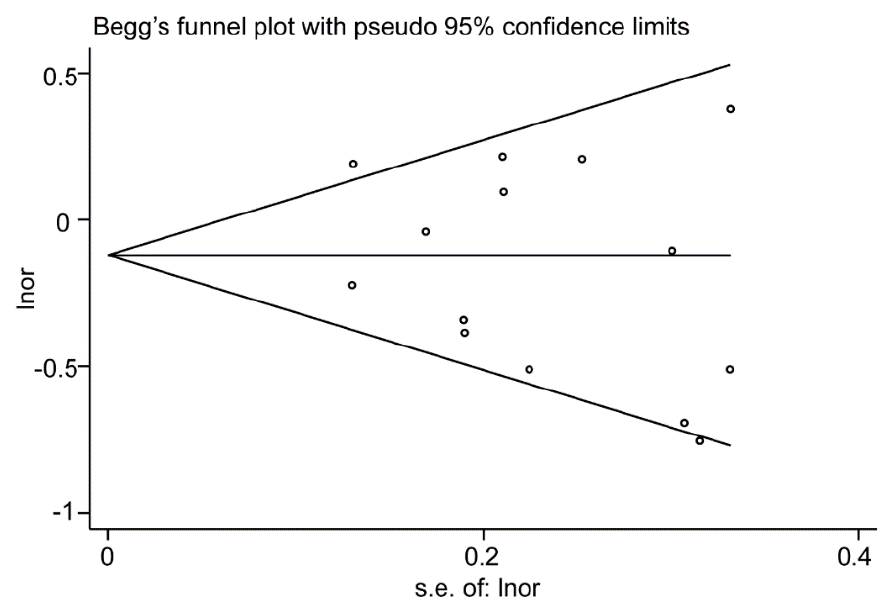
Figure 3. Funnel plot of the meta-analysis for the association between total dietary fiber intake and risk of endometrial cancer.